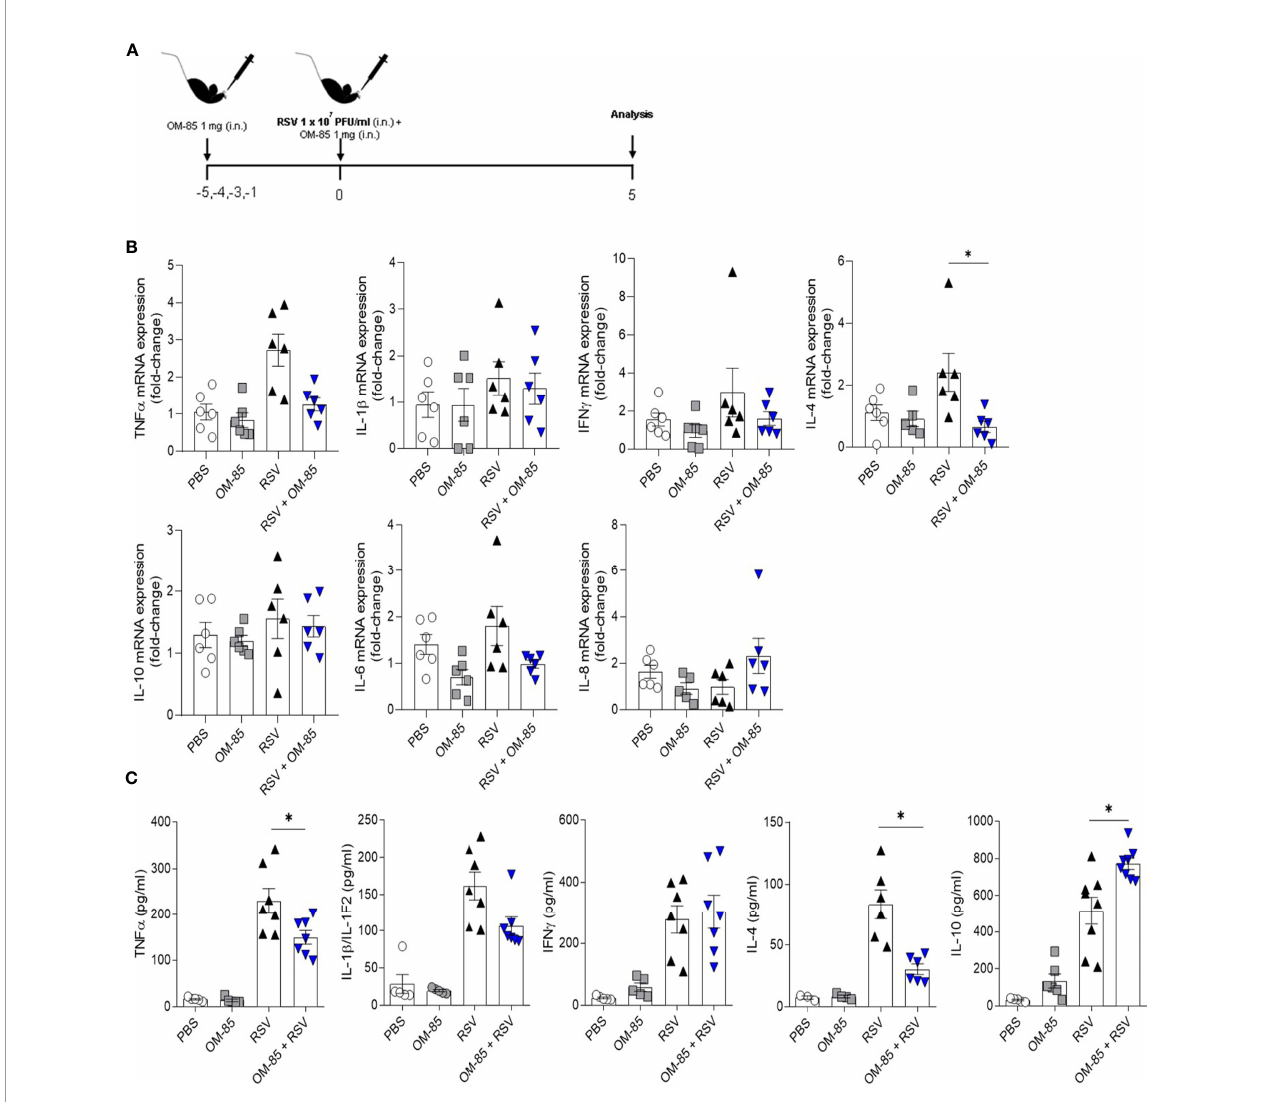
FIGURE 5 | Preventive treatment with OM – 85 reduces the pro – in fl ammatory cytokines production due RSV infection in the lungs. Mice were treated intranasally with OM – 85 (1mg) 5 days prior to RSV infection (four OM – 85 delivery). Afterwards, mice were infected with RSV (1x10 7 PFU/ml) and received another OM – 85 boost 6h later. BAL and lung were harvested at day 5 post – infection. (A) Experimental design. (B) Tnfa, Il1b, Ifng, Il4, Il10, Il6 and Cxcl15 (IL – 8) gene expression in the lungs detected by real – time PCR (fold change compared to untreated/uninfected control). (C) Production of TNF a , IL – 1 b , IFN g , IL – 4 and IL – 10 in the lungs measured by ELISA. All data are expressed as mean±SEM. Multiple groups were compared using Kruskal – Wallis. * p